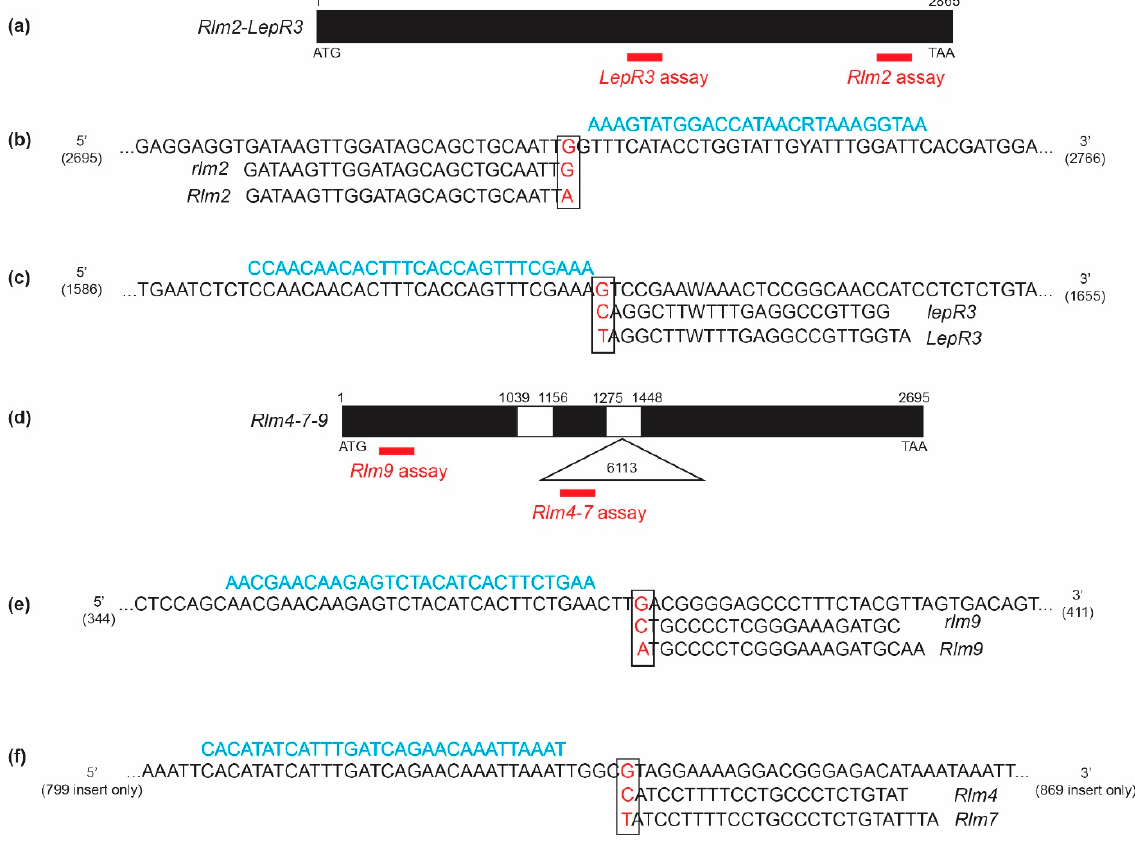
Figure 1. Location and flanking sequences of the Kompetitive Allele-Specific PCR (KASP) markers for B. napus resistance genes, Rlm2 , LepR3 , Rlm4 , Rlm7 and Rlm9 . Location of the LepR3 and Rlm2 assays within the Rlm2-LepR3 gene ( a ) and the Rlm9 , Rlm4 and Rlm7 assays within the Rlm4-7-9 gene region ( d ). Exons are indicated in black, introns in white and the 6113 bp insertion characteristic of Rlm4 and Rlm7 alleles are indicated by the triangle. The primer binding sites, flanking sequences and targeted SNP for the Rlm2 ( b ) , LepR3 ( c ), Rlm9 ( e ) and Rlm4 / Rlm7 ( f ) KASP assays are provided. The common primer for each assay is indicated in blue, whilst the allele-specific primers for each gene are highlighted in black with the targeted SNP indicated in red. Nucleotide positions of the flanking sequences within the genes are provided. Table 3. Thermal cycling conditions for KASP assays using the Quantstudio 5 machine.